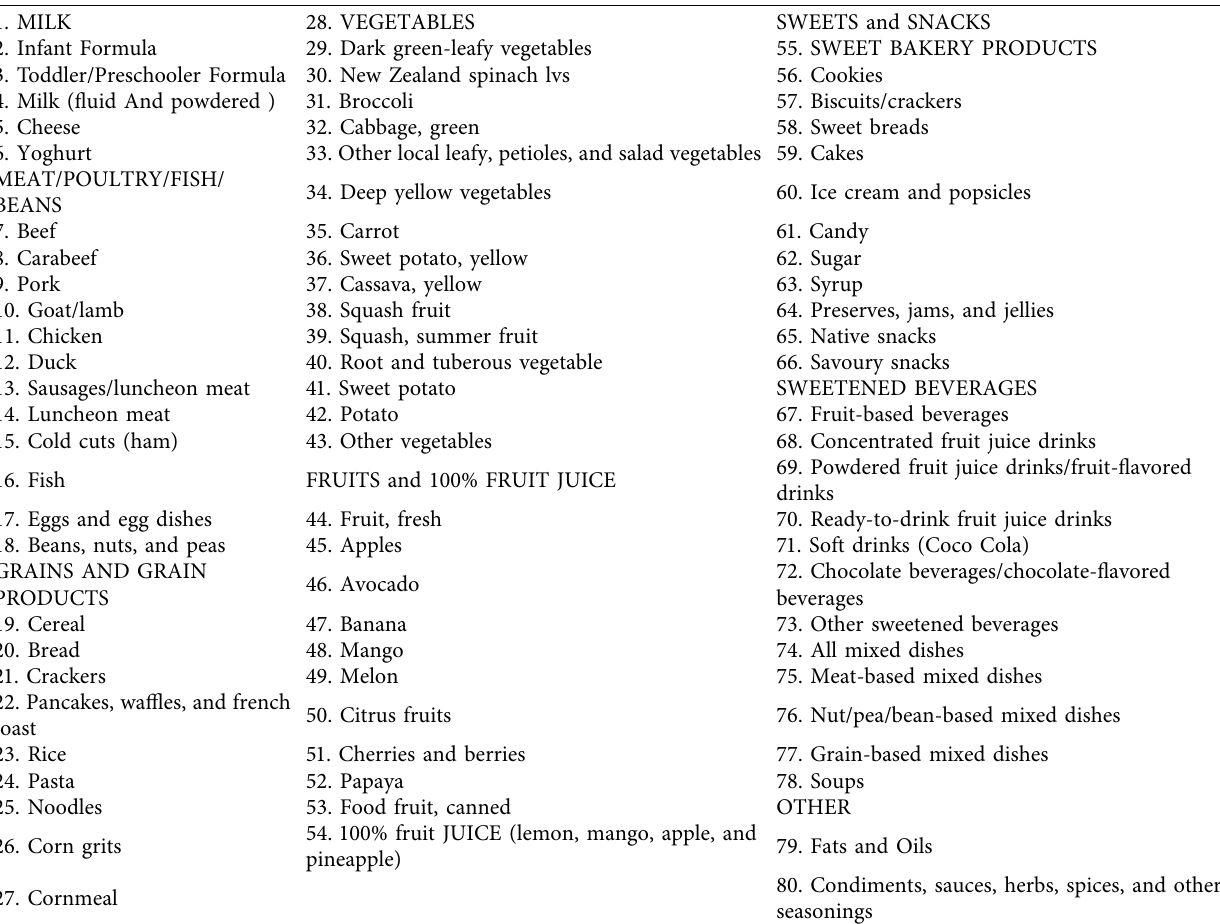
Table 1: Food group classification.